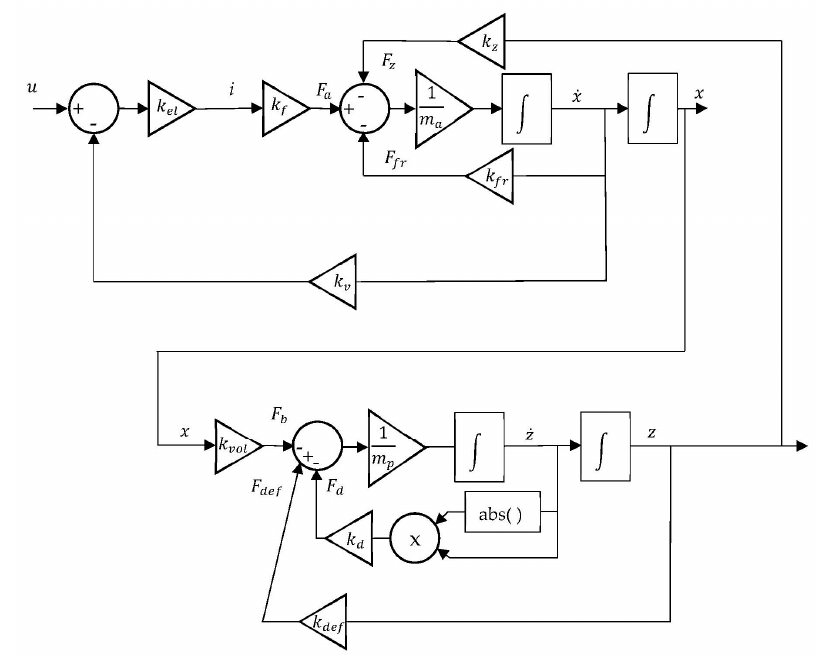
Figure 6. Prototype depth model block diagram.